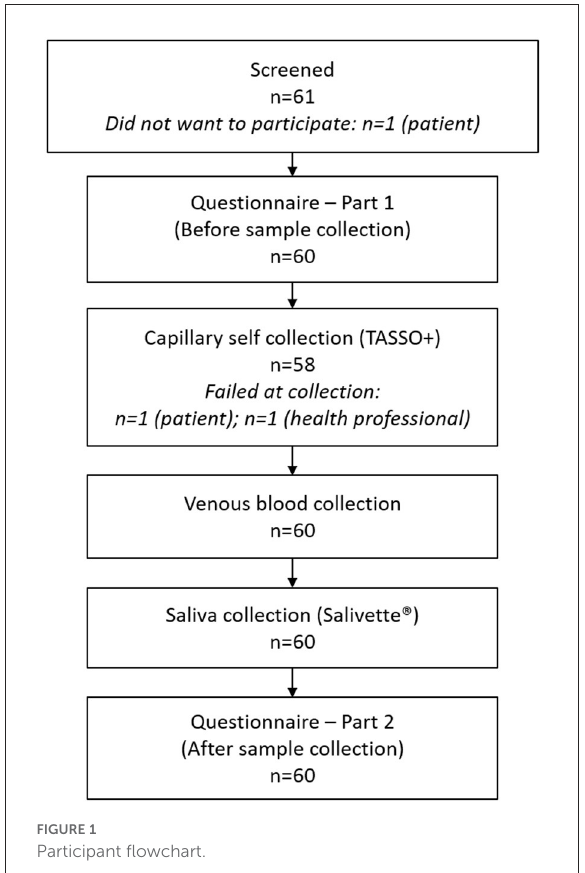
FIGURE1 Participant flowchart.